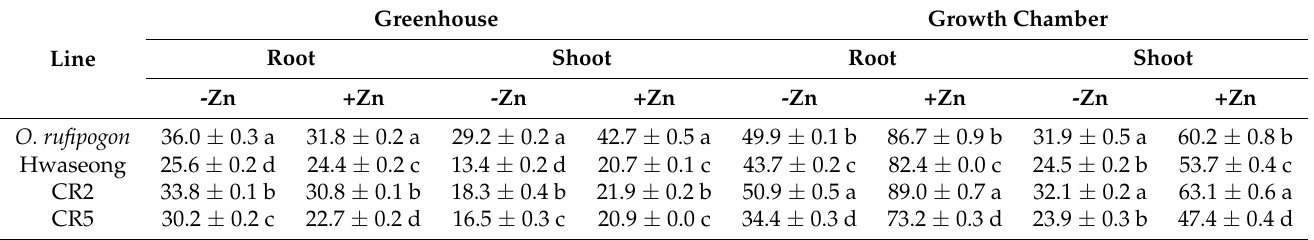
Table 4. Zinc content in root and shoot of rice genotypes grown under -Zn and +Zn treatments. Greenhouse Growth Chamber